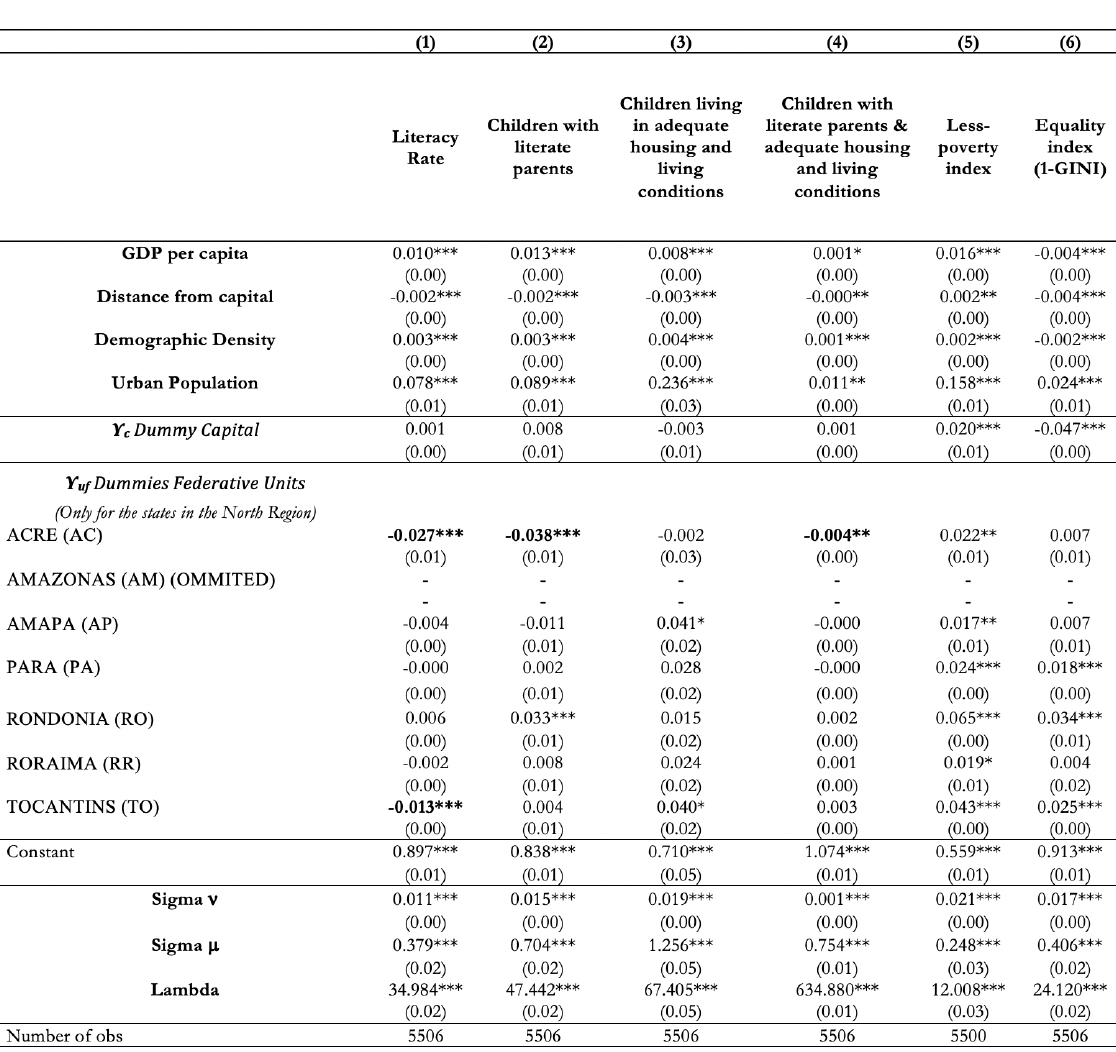
Table 5: Social Regressions MODEL